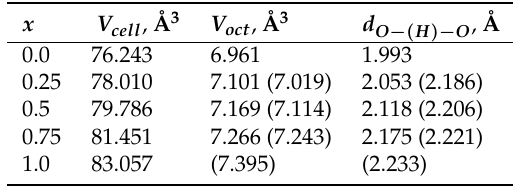
Table 1. The structural properties of FeO 2 H x for various hydrogen concentrations, x (left column). The second column is the unit cell volume. The third column is the volume of octahedra (the values in parenthesis correspond to second type of Fe). The right column is the distance between the nearest oxygen atoms (via hydrogen in